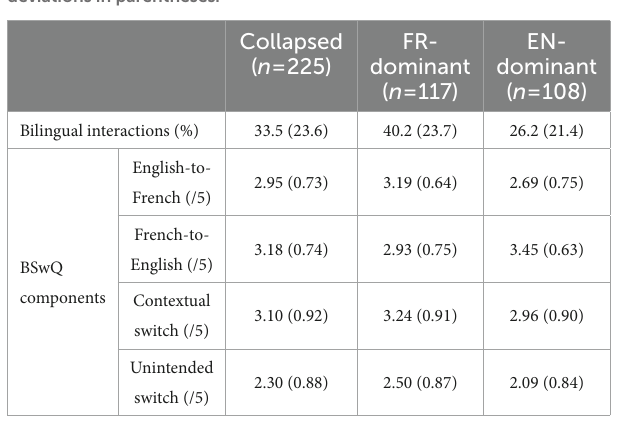
TABLE 3 Participants’ code-switching habits. Means with standard deviations in parentheses.